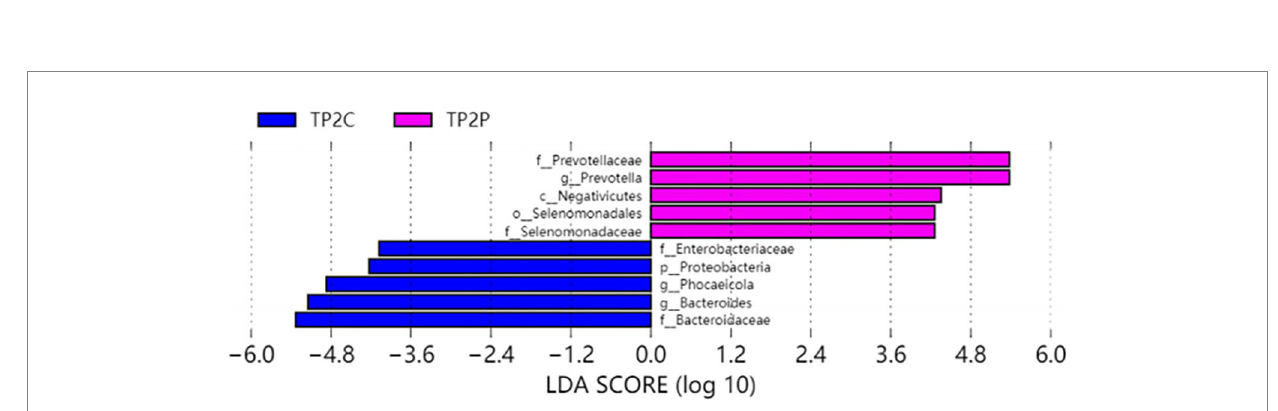
FIGURE 3 Differently abundant taxa identified using LEfSe analysis. Visualization of only taxa meeting an LDA threshold